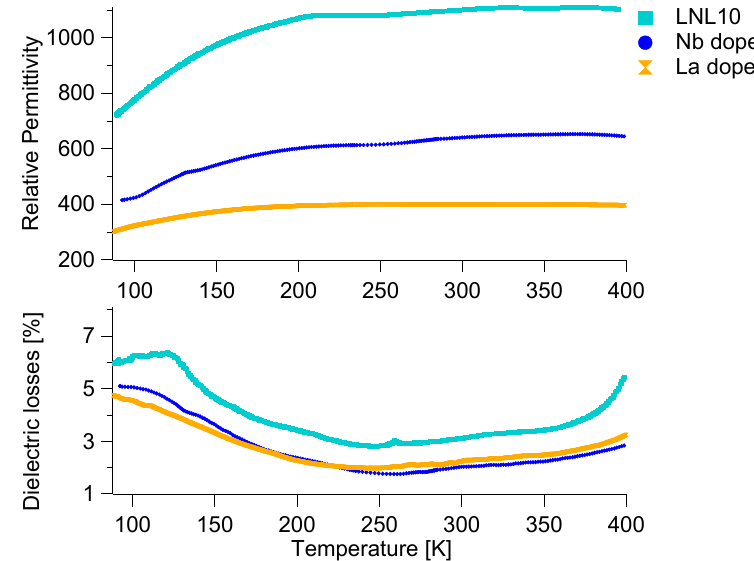
Figure 3. Temperature dependence of the relative permittivity and dielectric losses at 100 kHz of Nb- and La-doped BaTiO 3 films and of an LNL10 multilayer structure.